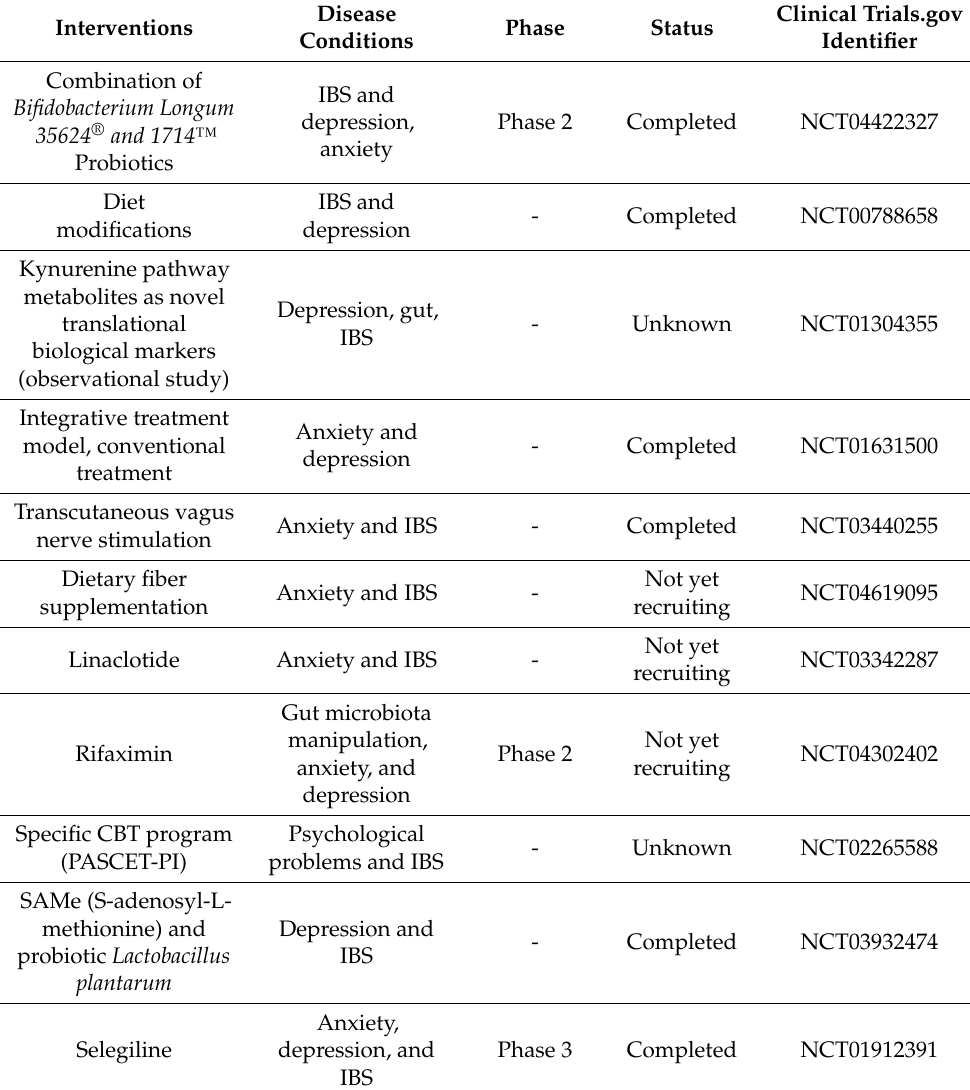
Clinical Trials.gov